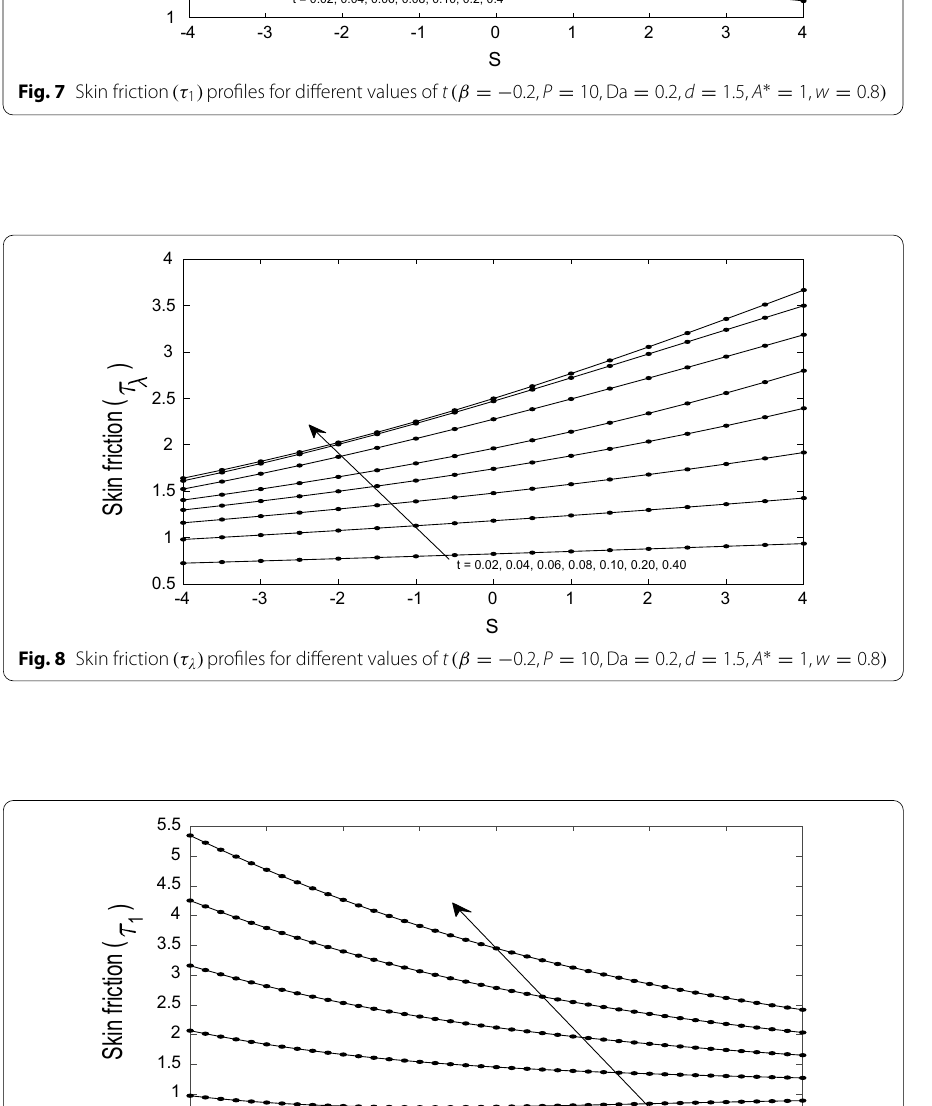
Fig. 9 Skin friction (τ 1 ) profiles for different values of S and P ( t